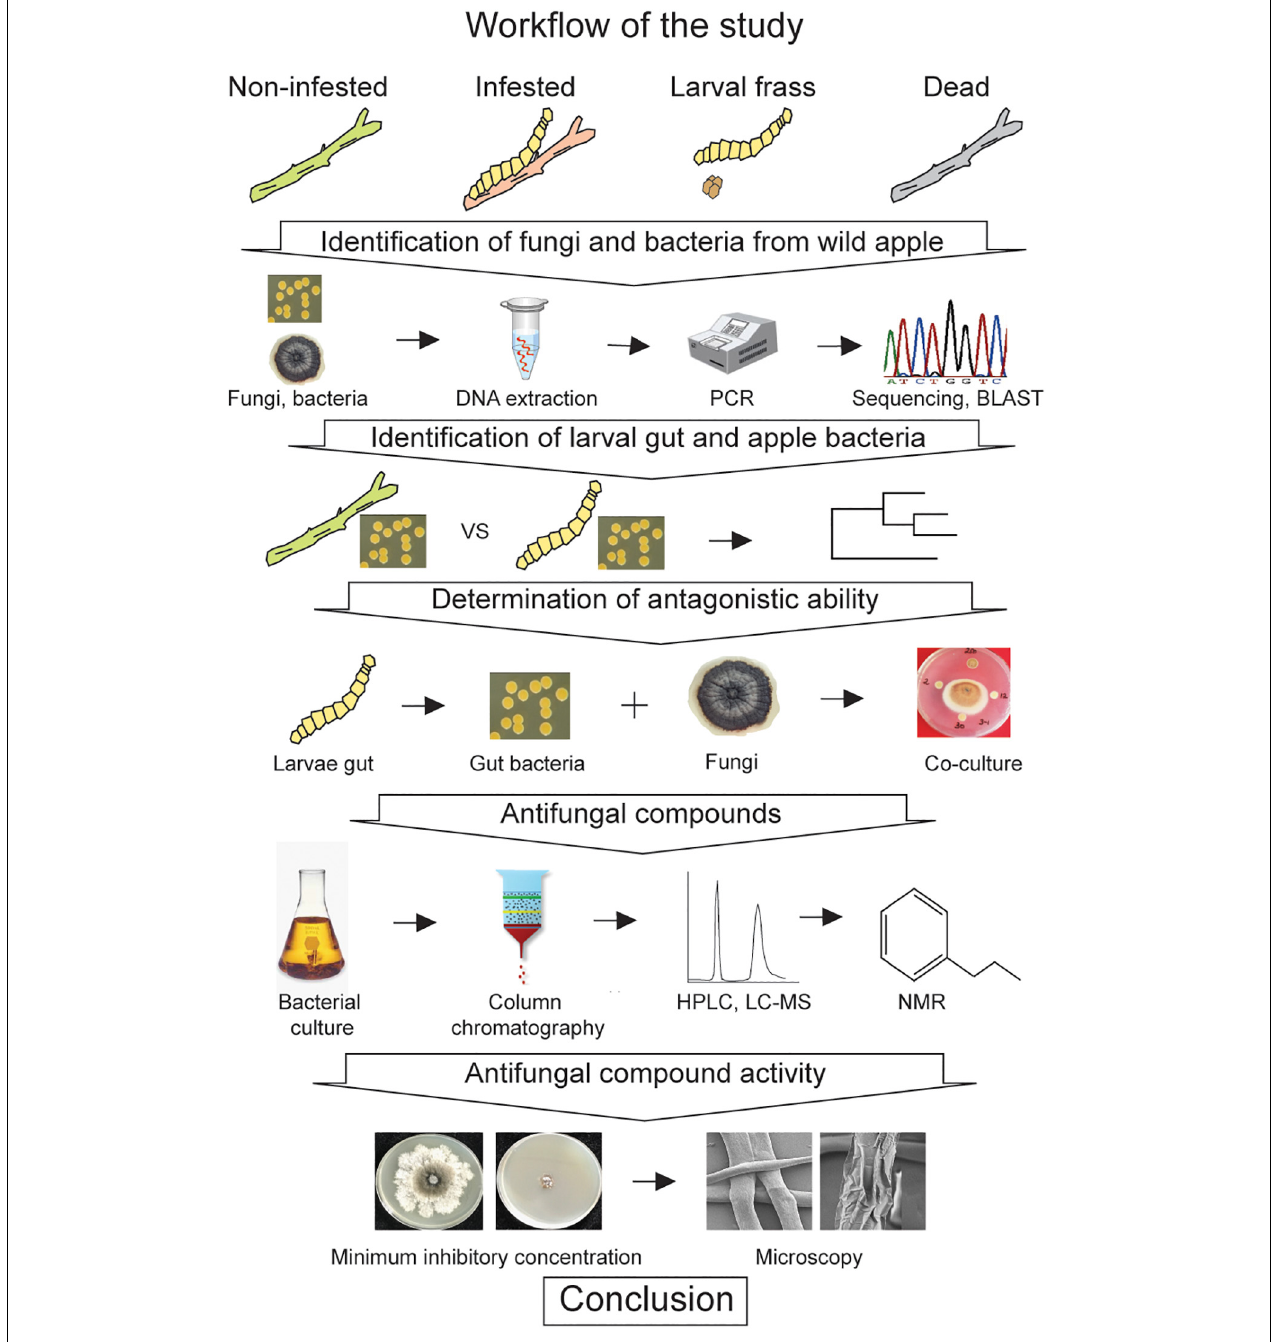
FIGURE 1 | A workflow depicting the strategy used to investigate the gut microbiota against the wild apple-associated fungi.